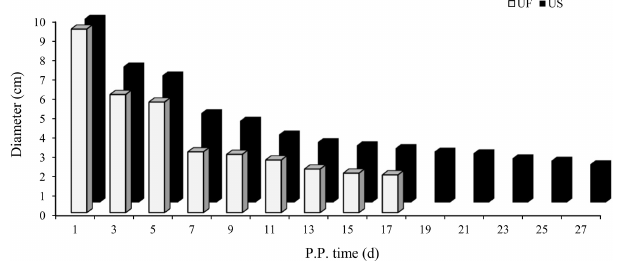
Figure 1. Trends for maximum cross-sectional diameter of the postpartum uterine horn between UF and US